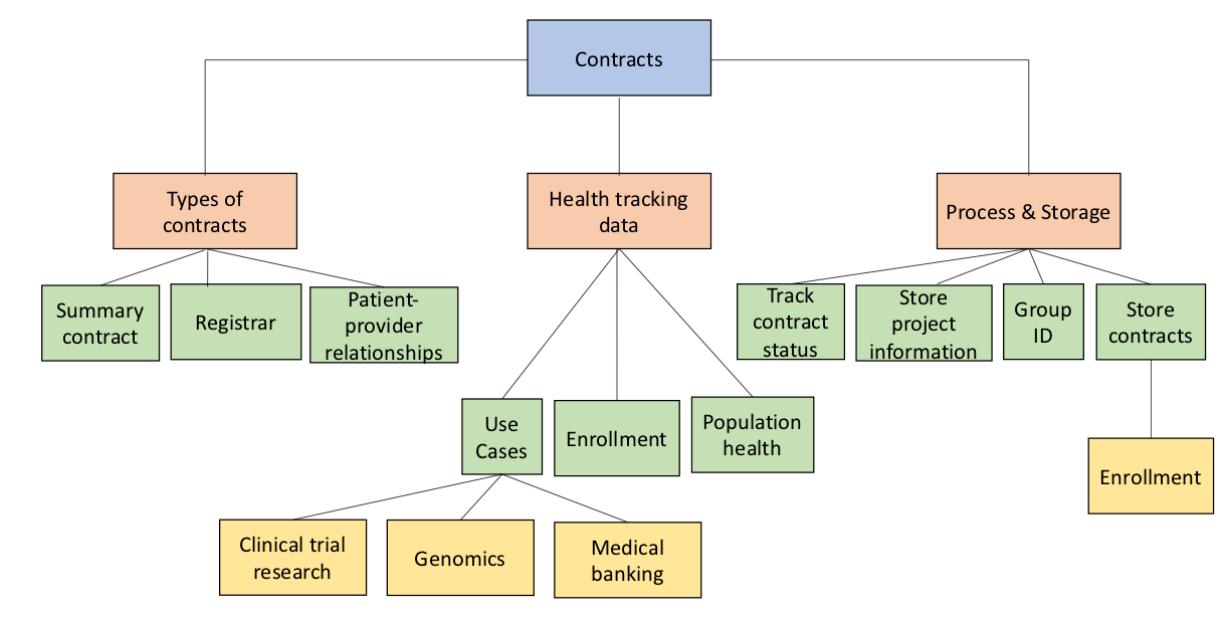
Figure 3. Smart contracts